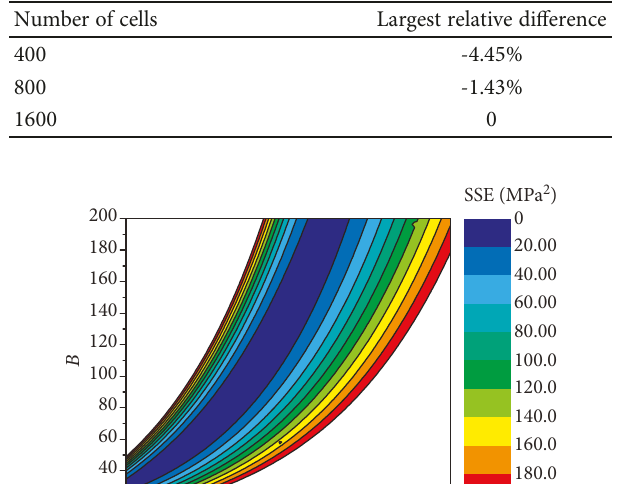
Table 3: Grid convergence analysis.